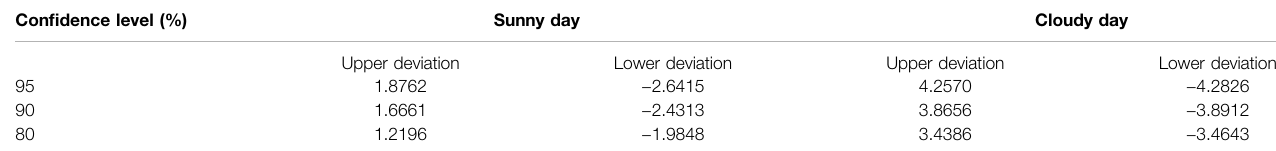
TABLE 3 | Upper and lower deviation values of prediction interval corresponding to Different Con fi dence Levels. Con fi dence level (%)